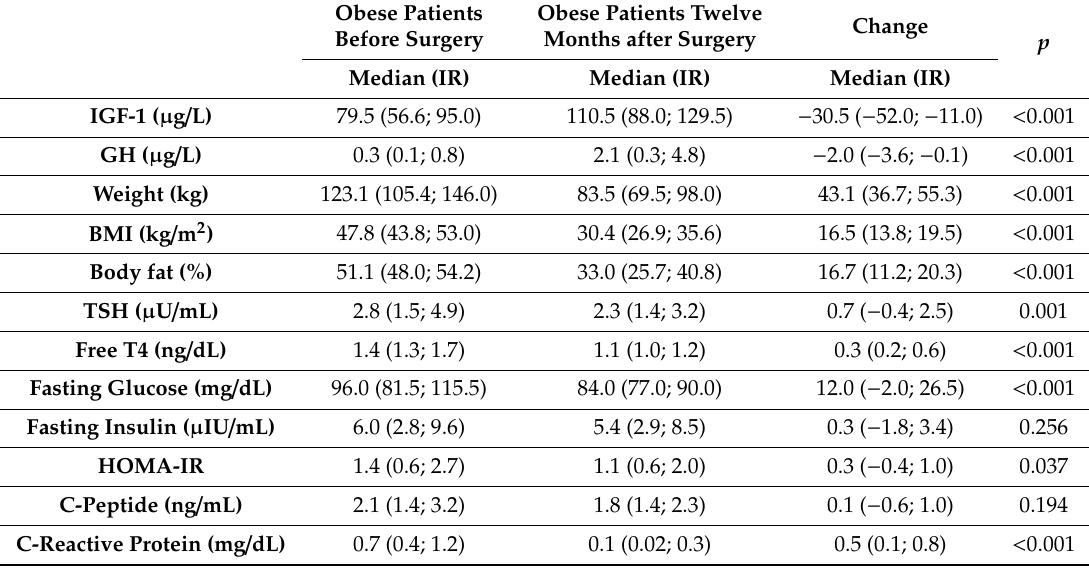
Table 3. Anthropometric, biochemical and hormonal data in obese patients before and twelve months after bariatric surgery. Obese Patients Obese Patients Before Surgery